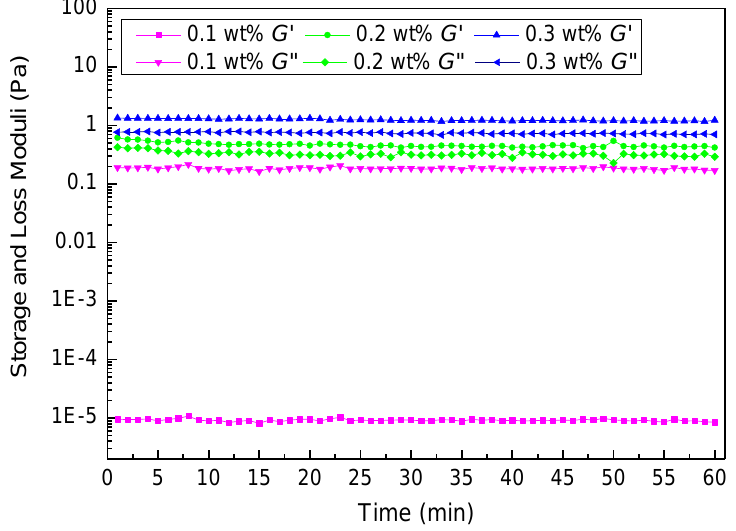
Figure 13. The G (cid:48) and G (cid:48)(cid:48) as a function of time for tested fluids at 80 ◦ Figure 13. The G’ and G’’ as a function of time for tested fluids at 80 °C.